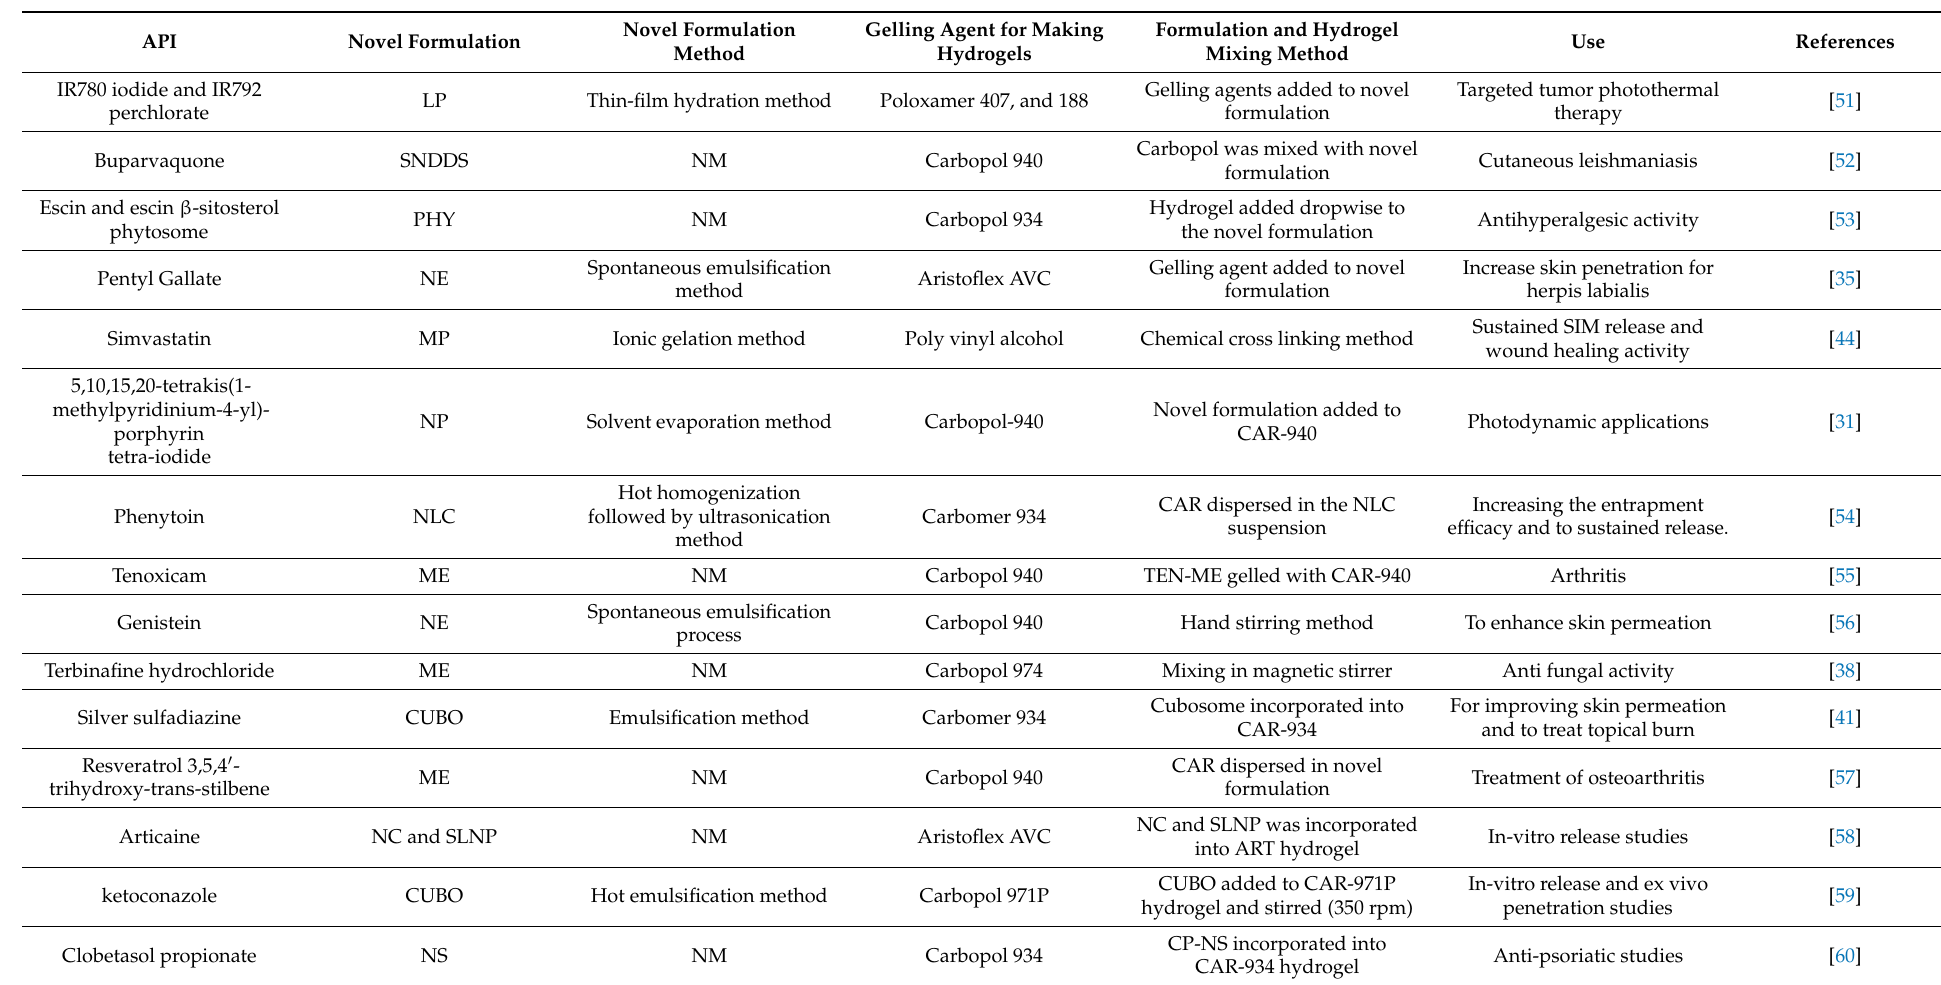
Table 5. Novel formulation formulated with synthetic gelling agents, preparation methods, mixing with the hydrogels, and its